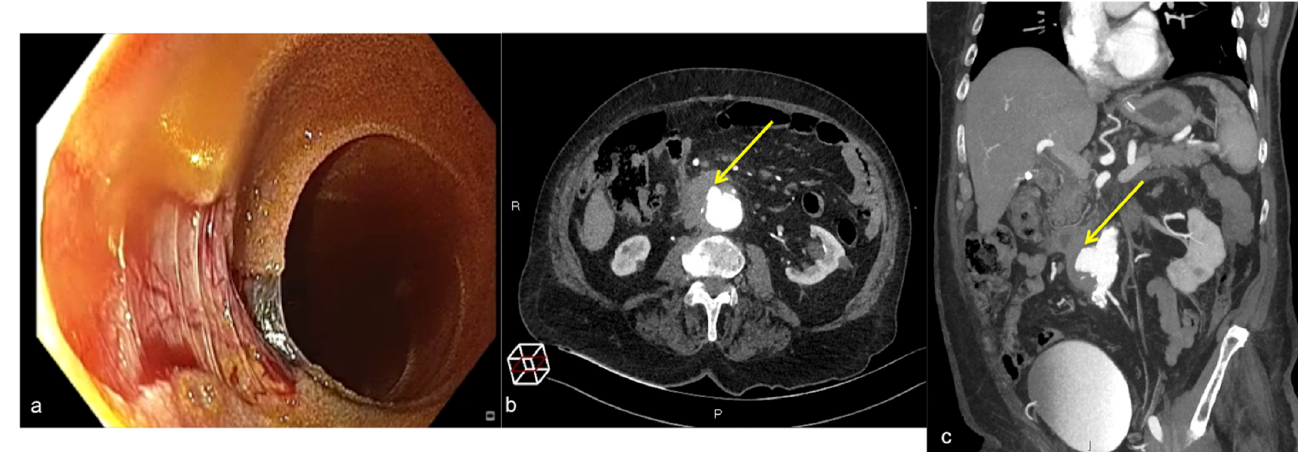
Figure 27. CTA multiphasic study of a gastric Dieulafoy lesion. In the arterial phase ( a ) and relative endoscopic evaluation ( b , c ), a vascular sub-mucosal lesion is identified.